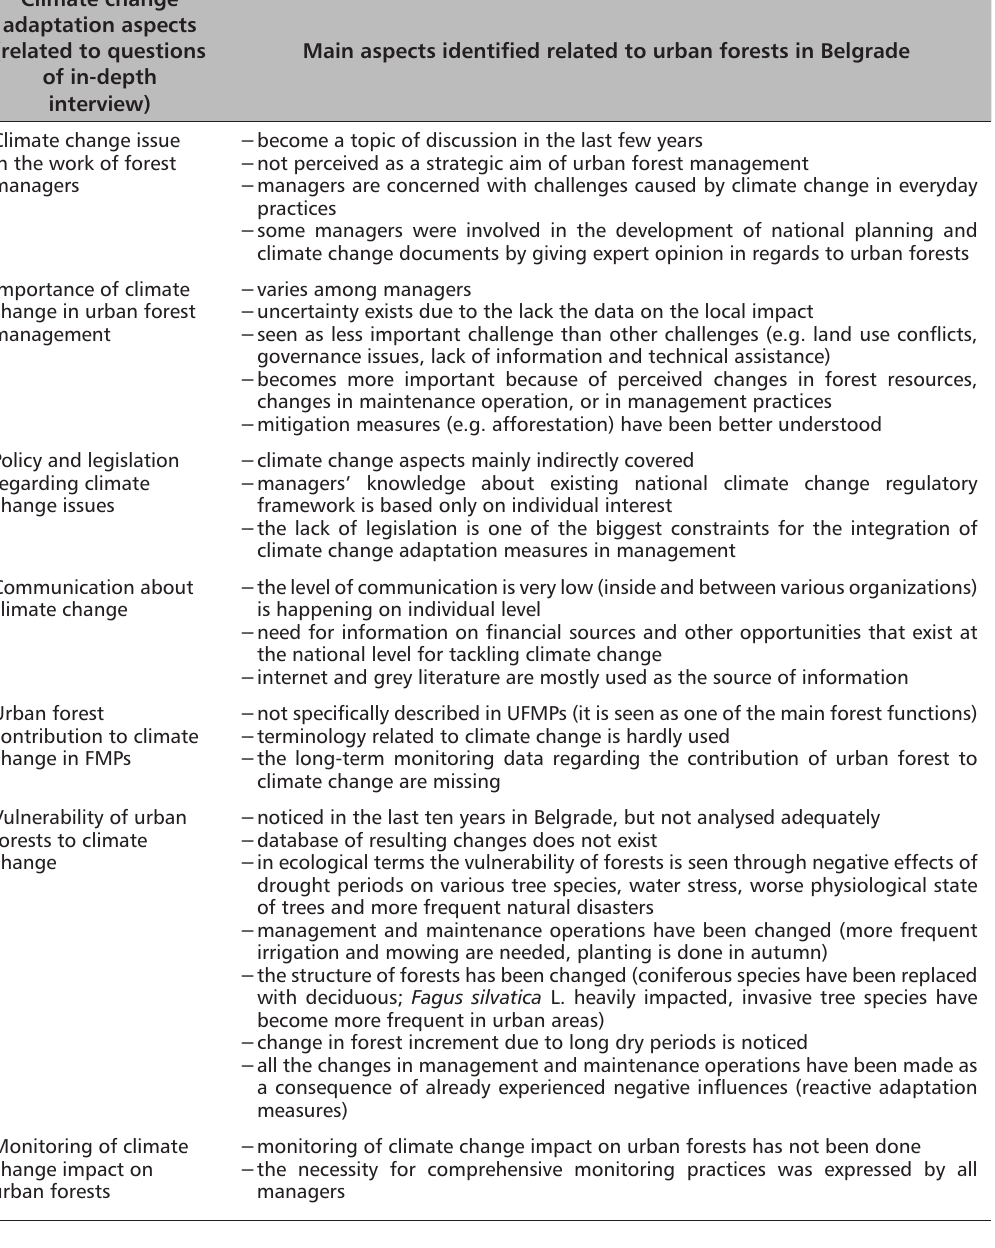
TABLE 3. Summary of main aspects revealed through in-depth